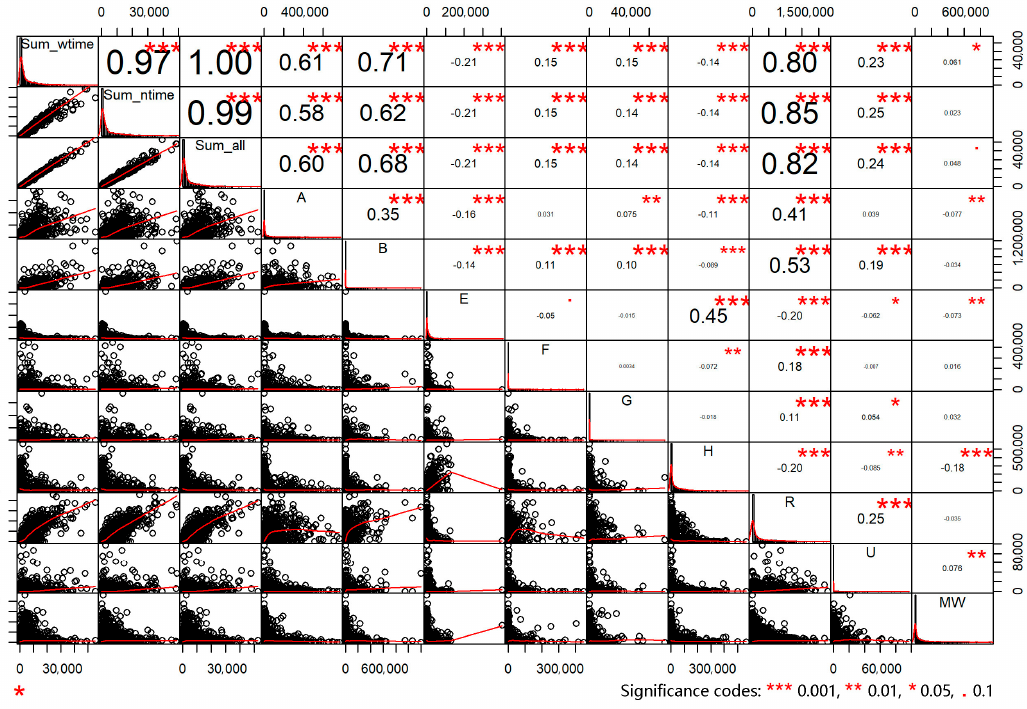
Figure 7. Variable scatter plot. Table 5. Parameter Table 6. Building use regression ( BUR) diagnostics 1 .